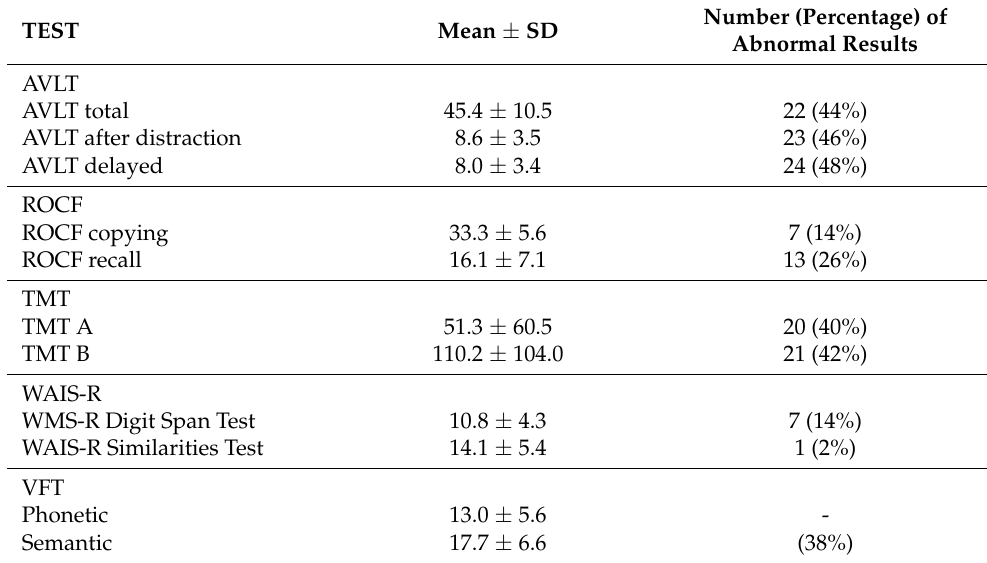
Table 2. Results of neuropsychological tests in the study group (SD—standard